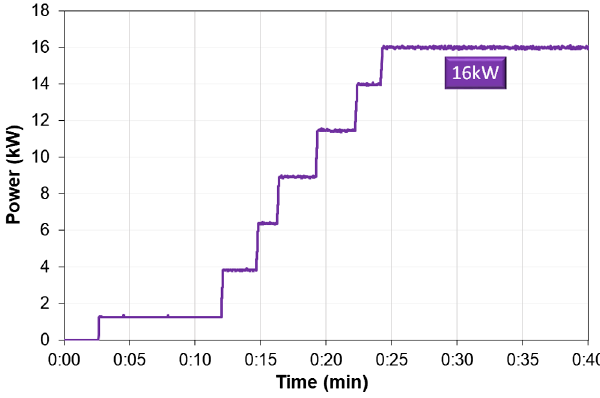
FIG. 4. Beam power ramp-up to 16 kW.